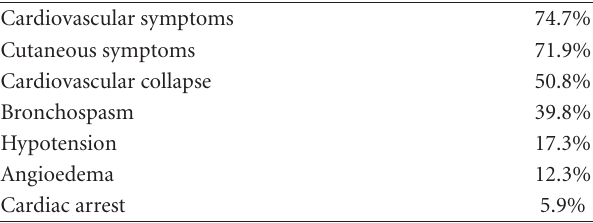
Table 1: Clinical manifestations of drug hypersensitivity [22].